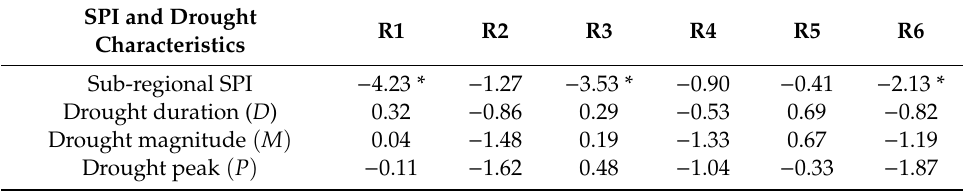
Table 4. Trend of SPI and drought characteristics from 1961 to 2004 in the six sub-regions.